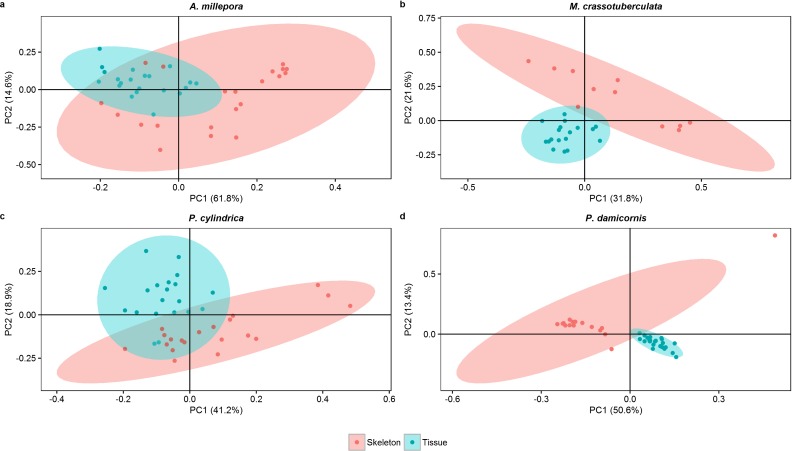
Score plot of principal component analysis of fatty acid and fatty alcohol profiles (based on % fatty acids) of denuded skeleton and isolated tissue of four scleractinian species prepared with the air-spraying method (ellipses show 95% confidence intervals).